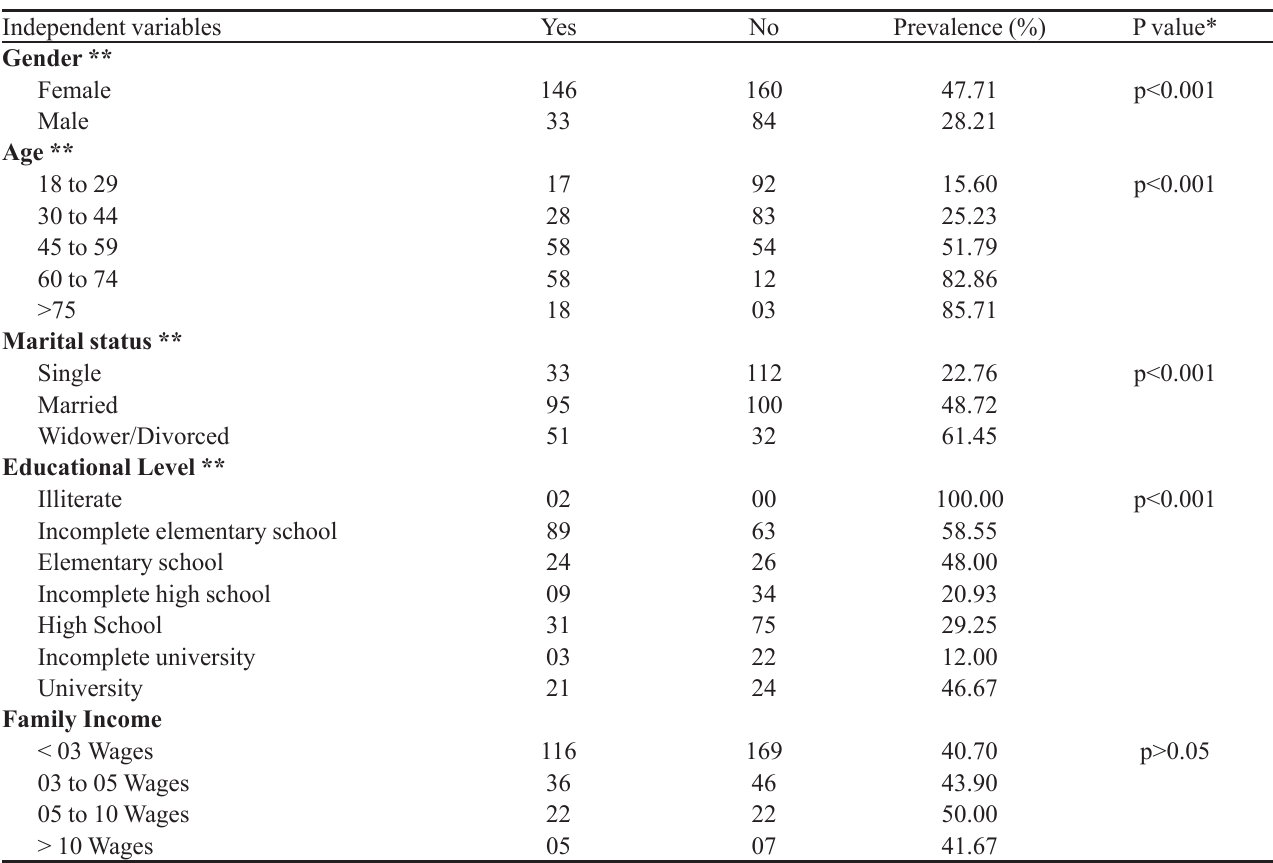
TABLE I - Absolute frequency and prevalence of prescription medicine use by respondents according to demographic and socio- economic factors